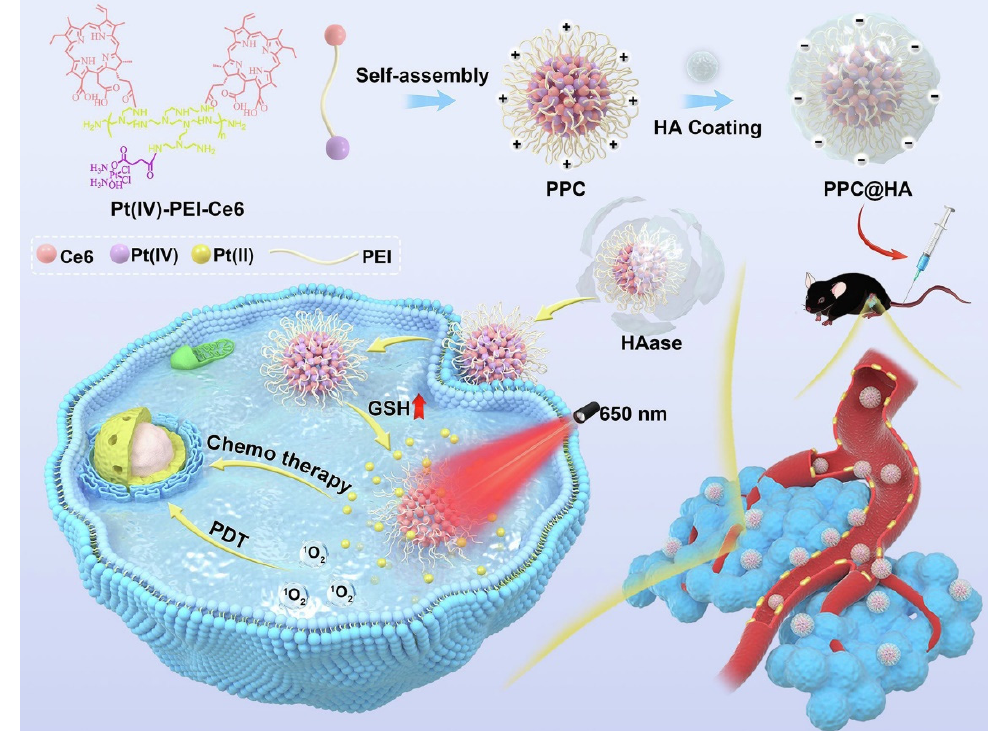
Figure 7. Synthetic procedure of charge-reversal micelles (PPC@HA) and schematic illustration of the targeted drug delivery and enhanced cellular uptake of the designed chemo-photodynamic nanomedicine for anti-melanoma treatment. The HA coating increases the targeted delivery of PPC@HA into the tumor tissue, and hyaluronidase in the tumor tissue induces HA degradation to form positively charged PPC, resulting in enhanced cellular uptake by B16 cells. Finally, PPC@HA exhibits improved biodistribution in the tumor tissue and significantly inhibits tumor growth through chemo-photodynamic combination therapy. (Reprinted from [181], with permission from Elsevier).